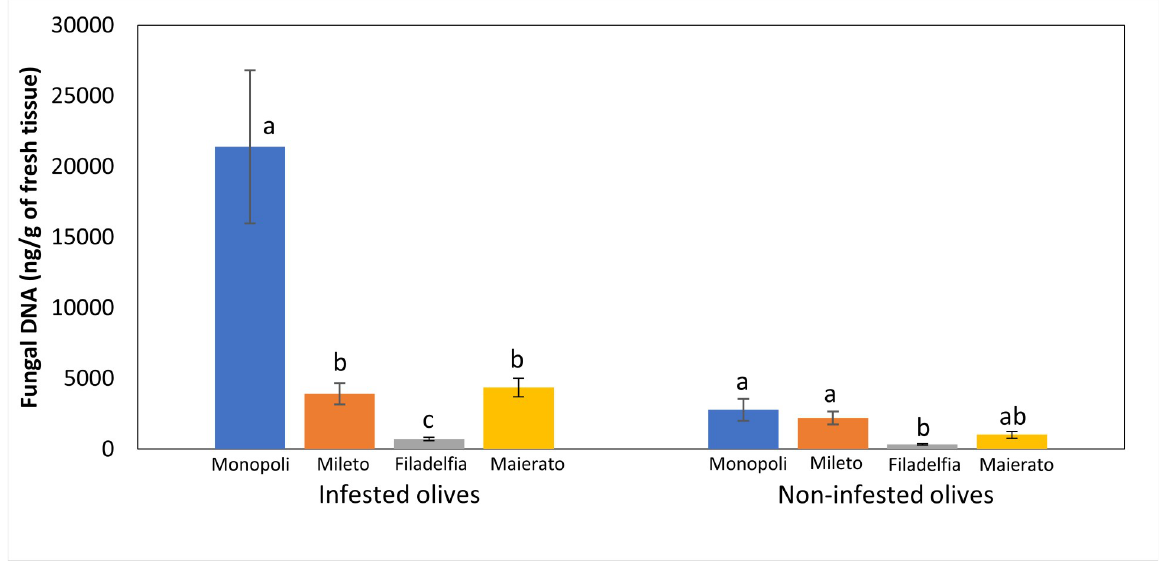
Fig 3. Estimated concentration of fungal DNA in olive samples collected in Monopoli, Mileto, Filadelfia and Maierato. Independent statistical analyses were performed for infested (left side) and non-infested (right side) olive samples. Different letters indicate significantly different values according to 2-sided tests (P � 0.05). Bars indicate standard errors of the means.